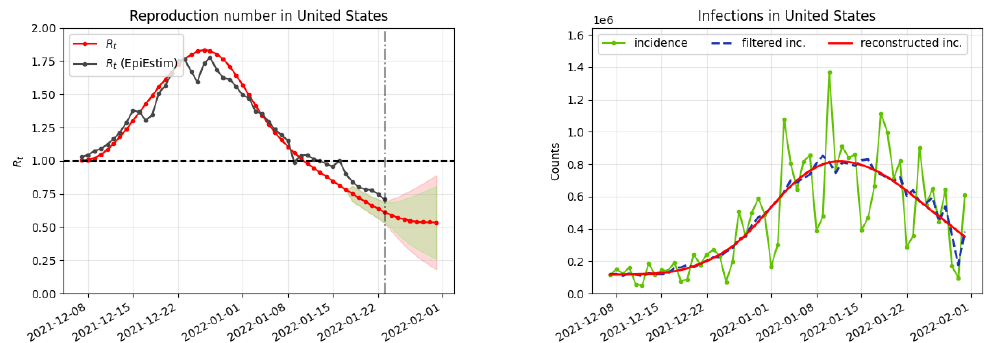
Figure 2. Illustration of the online inversion method [11]. On the left in red, the obtained reproduction number R t and in black its estimate obtained by the classic EpiEstim method. On the right in green, the original incidence curve i t of new cases, in blue the incidence curve ˆ i t corrected of the weekend and festive biases, and in red the final reconstructed incidence curve i r application of the renewal equation. Estimate obtained for USA on 1 February 2022.